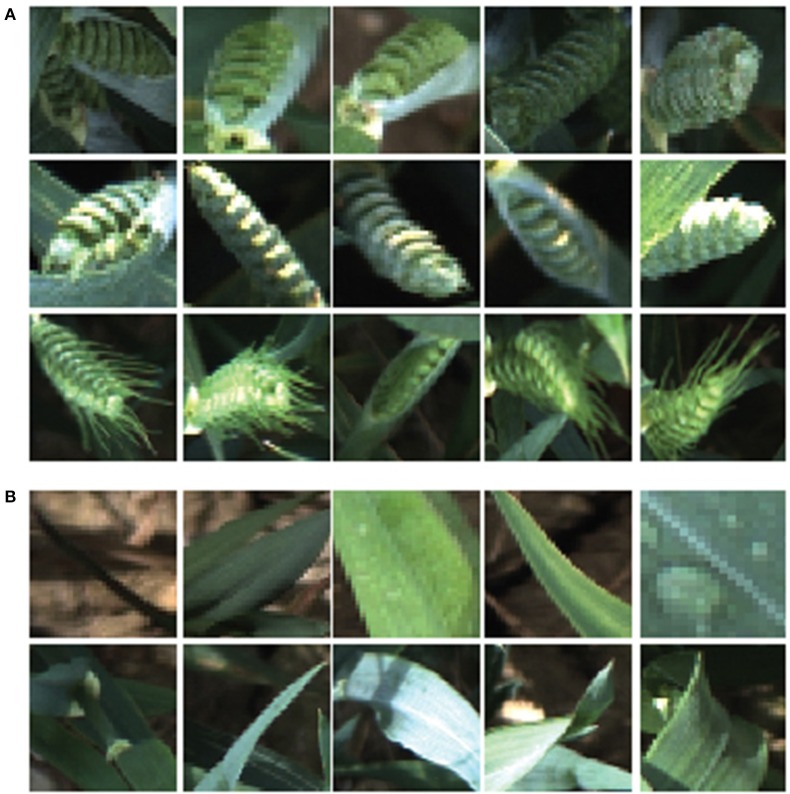
Example of ear emergence training patches. Note that the training patches are not necessarily of equal size and resized for illustration purposes. (A) Examples of positive training patches of three different wheat cultivars (Triticum aestivum L. cv. Soissons, Avalon, and Cadenza). (B) Examples of negative training image patches.